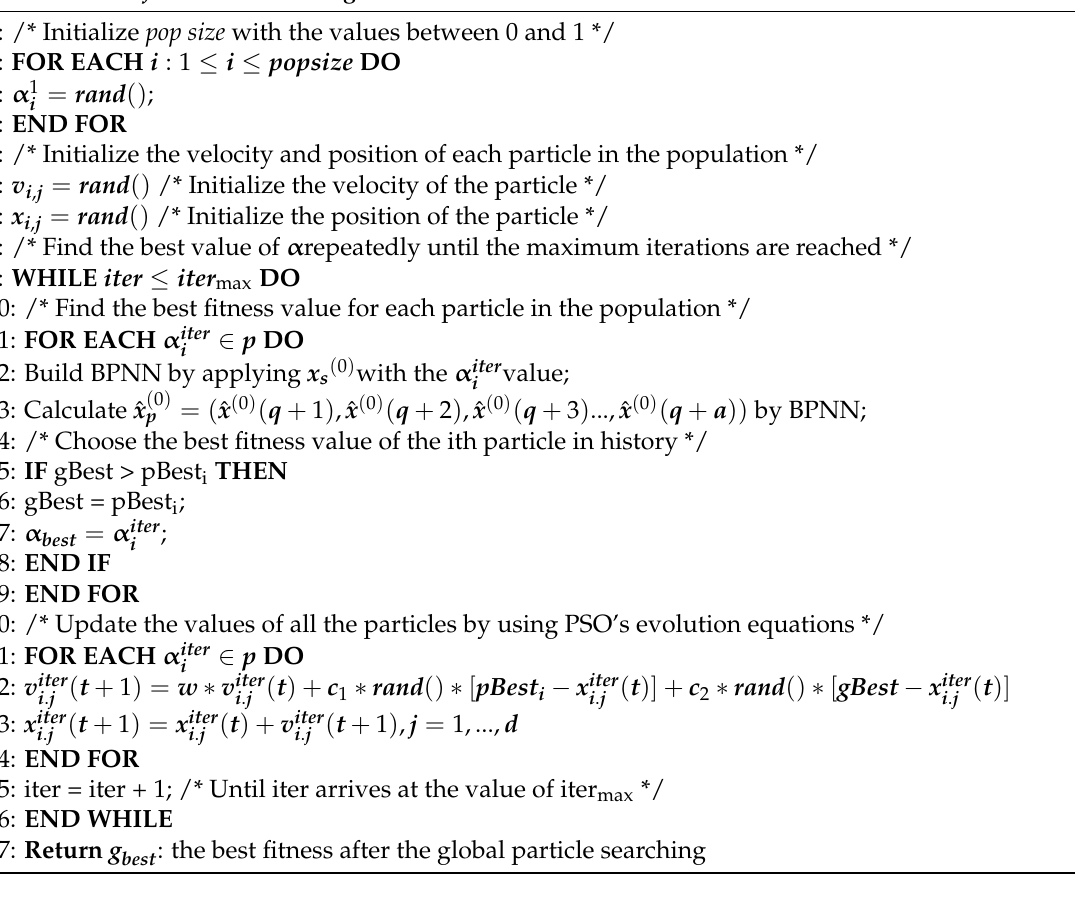
Pseudo-code of standard PSO